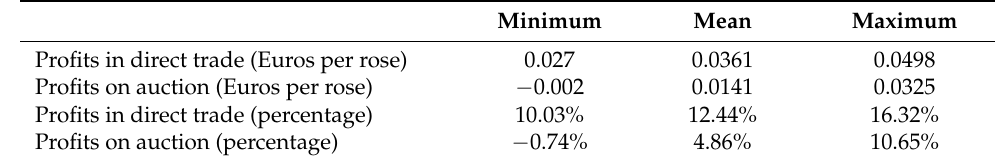
Table 3. Unit profits generated in the model (averages of all farms in 50 repetitions).